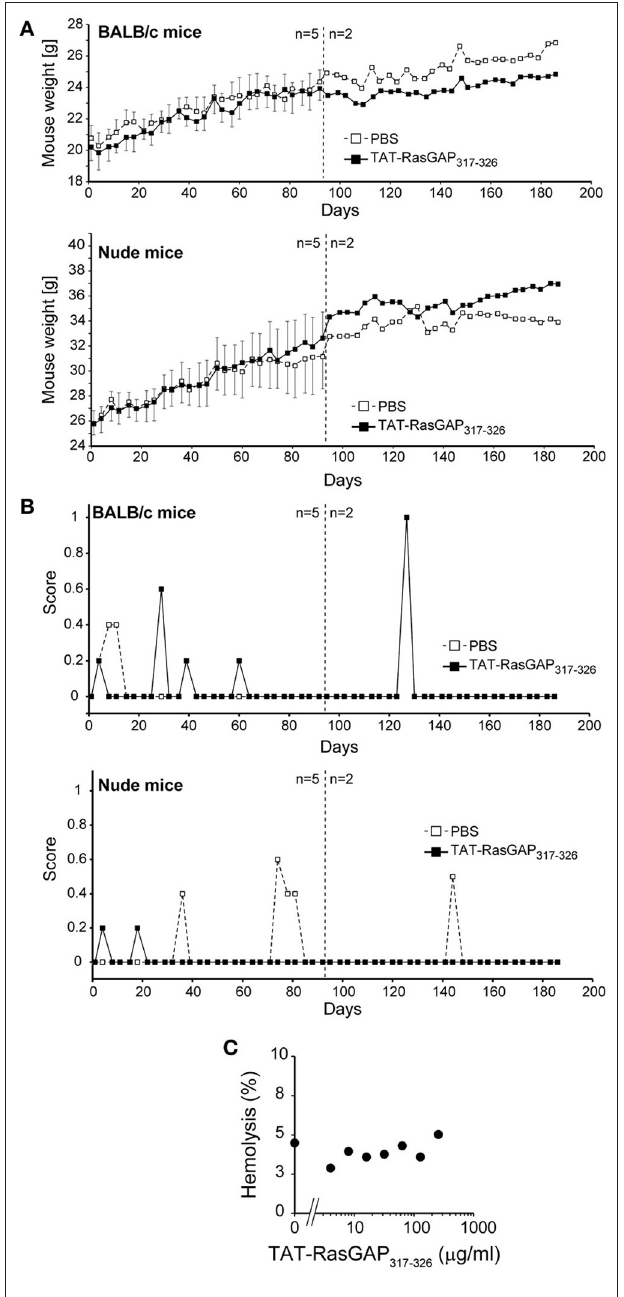
FIGURE 5 | TAT-RasGAP 317 − 326 does not alter mice health and does not trigger hemolysis. The indicated number of 8-week-old BALB/c and NMRI nude mice were i.p. injected twice a week with PBS or 1.6mg/kg TAT-RasGAP 317 − 326 (in PBS), weighed and evaluated for behavior and general aspect. After 90 days, three mice per group were sacrificed for organ inspection (A) Weight. The results correspond to the mean ± 95% CI. (B) General aspect and behavior score (see Section Materials and Methods). A score of 8 represents the limit above which mice need to be culled. (C) Hemolysis activity was determined by treating human red blood cells with various concentrations of TAT-RasGAP 317 − 326 . After 30min incubation at 37 ◦ C, sample tubes were centrifuged and the absorbance of the supernatant was measured at 540 nm. Maximum hemolysis (set at 100%) was triggered with 0.5 % triton-X treatment of